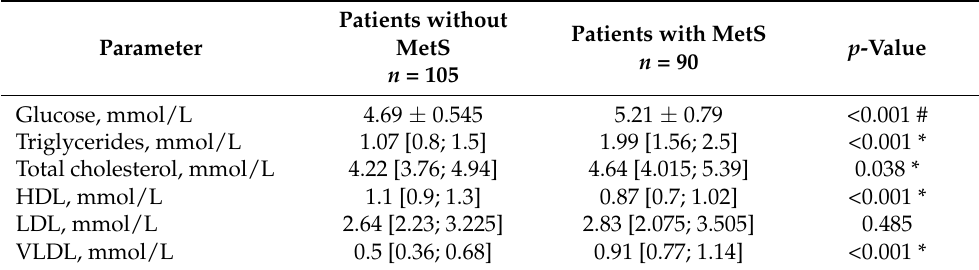
Table 2. Concentration of glucose and lipid spectrum in blood serum of patients without and with metabolic syndrome (mean ± SD; Me [Q1; Q3]). Patients without Parameter